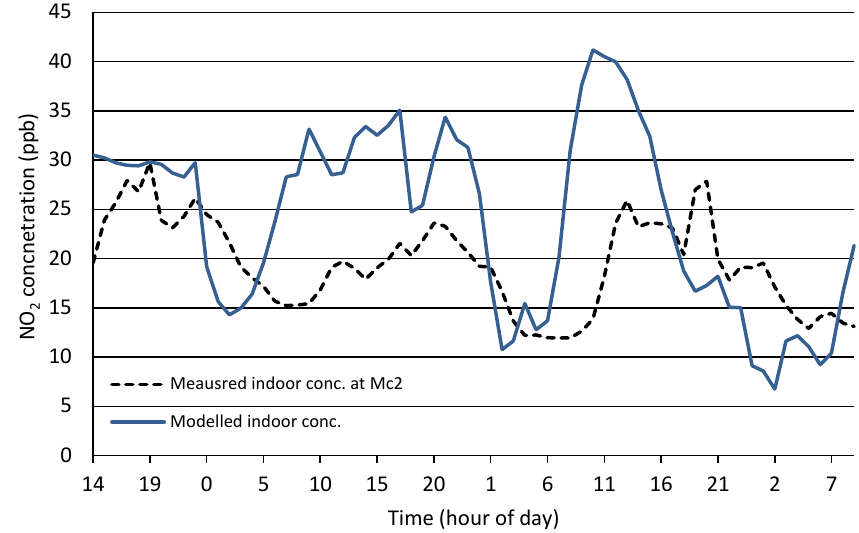
Figure 12. Modelled indoor NO 2 concentrations at M c 2 (using M c 3) vs. measured indoor concentrations.